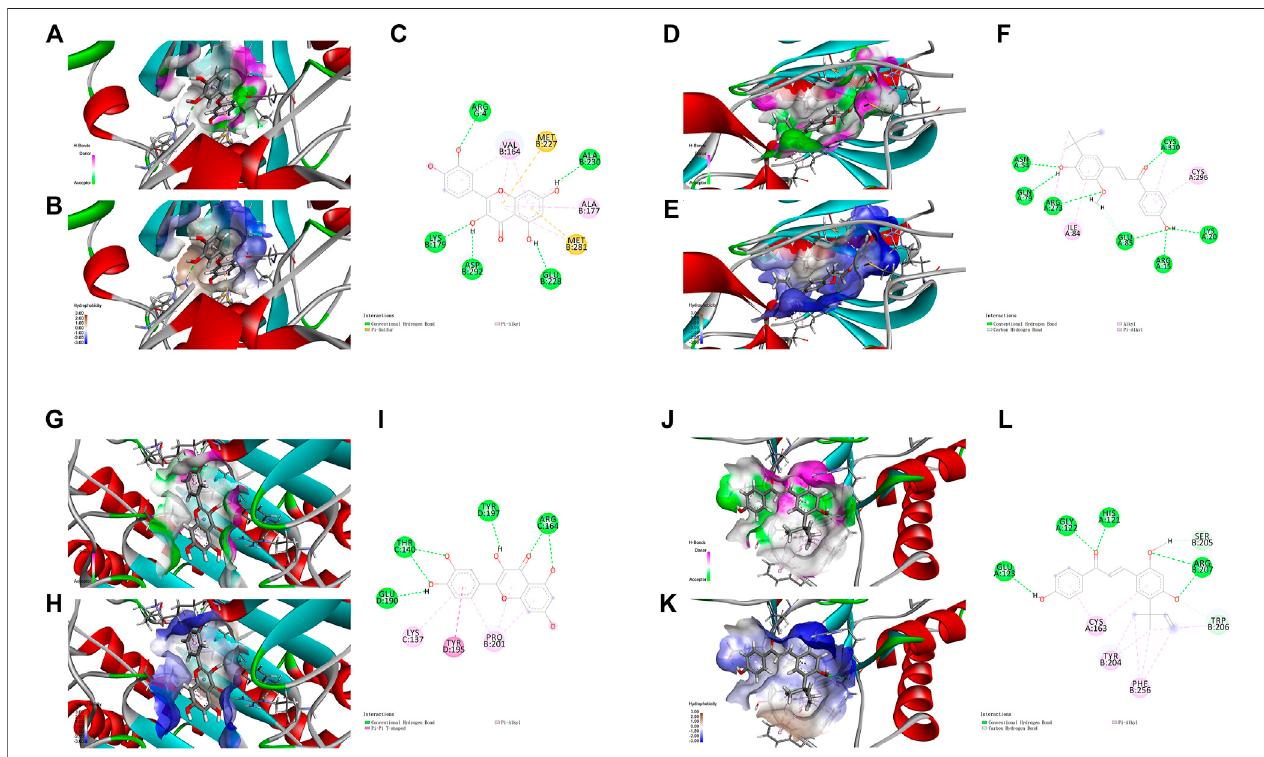
FIGURE 5 | Molecular docking analysis showing bond pattern of Akt1 and quercetin (A – C) , kaempferol (D – F) ; Caspase-3 binding to quercetin (G – I) , kaempferol (J – L) . (A,D,G,J) : Areas of the donor and acceptor of hydrogen bond (H-bond). (B,E,H,K) : Areas of hydrophobicity. (C,F,I,L) : Two dimensional patterns of bond.